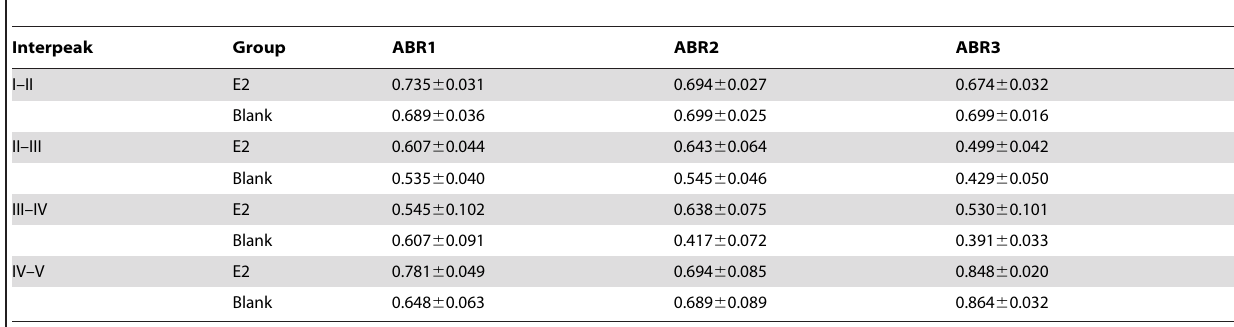
Table 5. Estradiol effects on click-evoked ABR interpeak latencies measured 20 dB above each animal’s threshold.